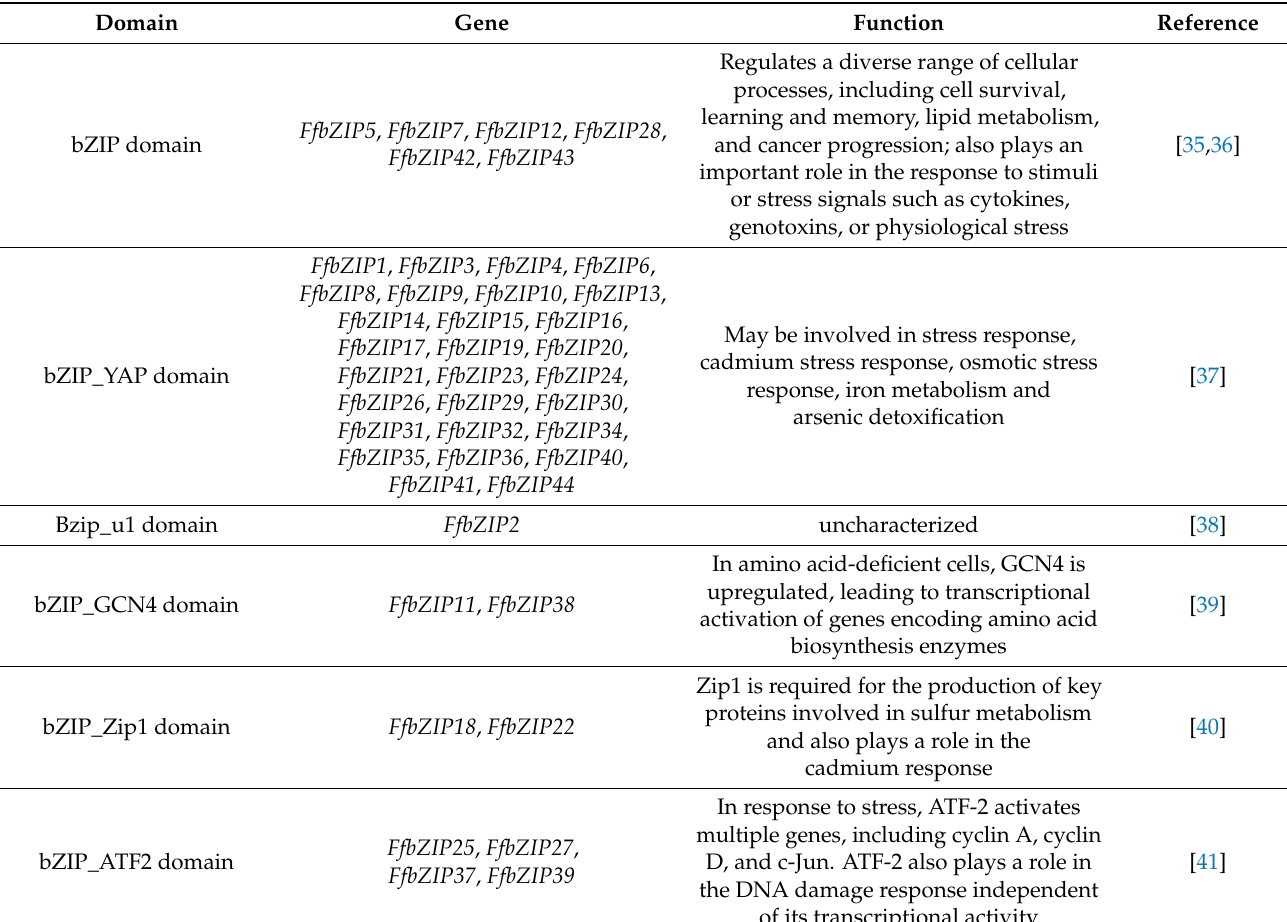
Table 2. FfbZIP transcription factor domains and their